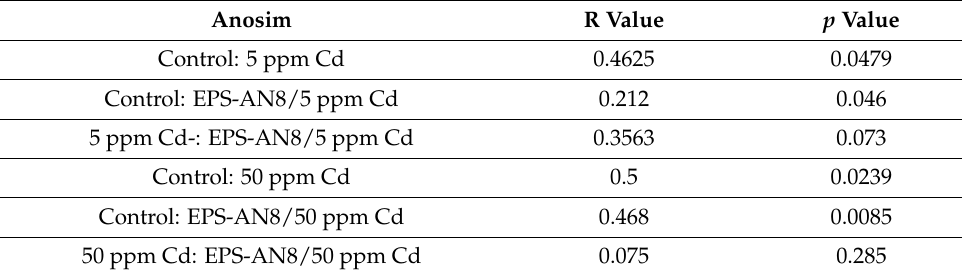
Table 2. Beta diversity of gut microbiota expressed through Adonis.